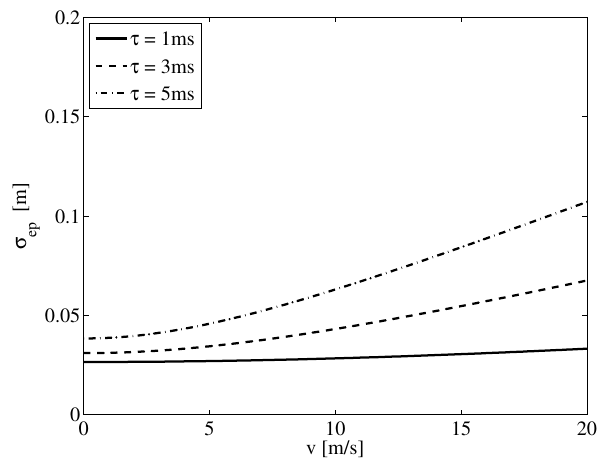
Figure 6: Target horizontal position standard deviation versus MAV horizontal speed v and sensor synchronization error τ assuming MAV flight altitude of ρ = 40 m and target size of d = 1 . 5